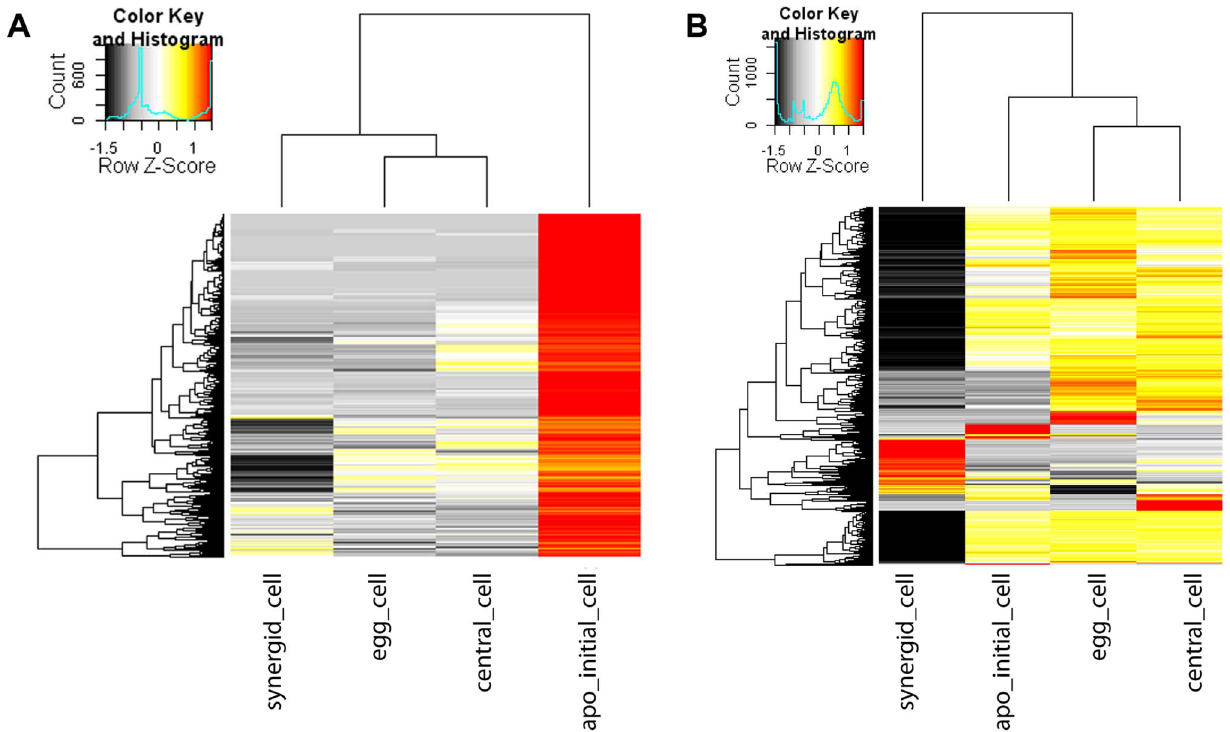
Figure 4. Heatmap of log2 transformed normalized read counts. Heatmap of 1’487 genes enriched in the Boechera AIC as compared to all cell types of the mature female gametophyte as identified using NOISeq-sim (A). Heatmap of 3’792 genes enriched in the AIC as compared to all cell types of the mature gametophyte or differentially expressed between any cell type of the mature gametophyte identified using EdgeR (B). The hierarchical clustering of samples and genes was based on euclidean distance and hierarchical agglomerative clustering. Colours are scaled per row and red denotes high expression and black low expression.